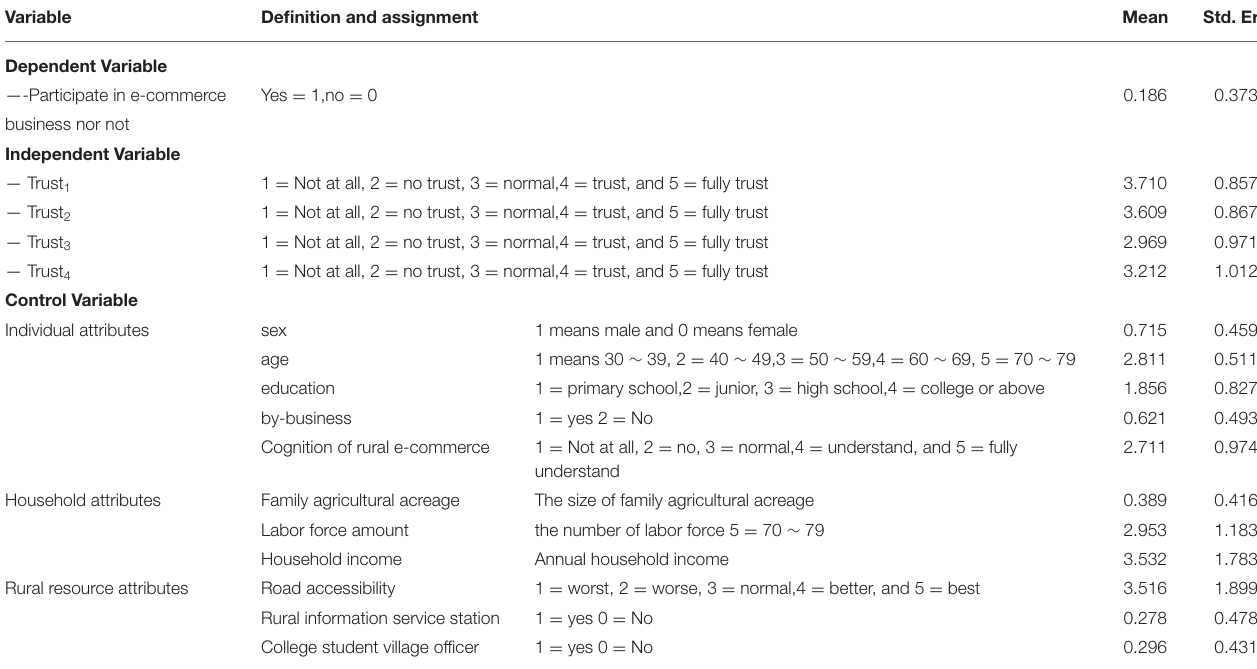
TABLE 3 | The descriptive statistics of variables. Variable